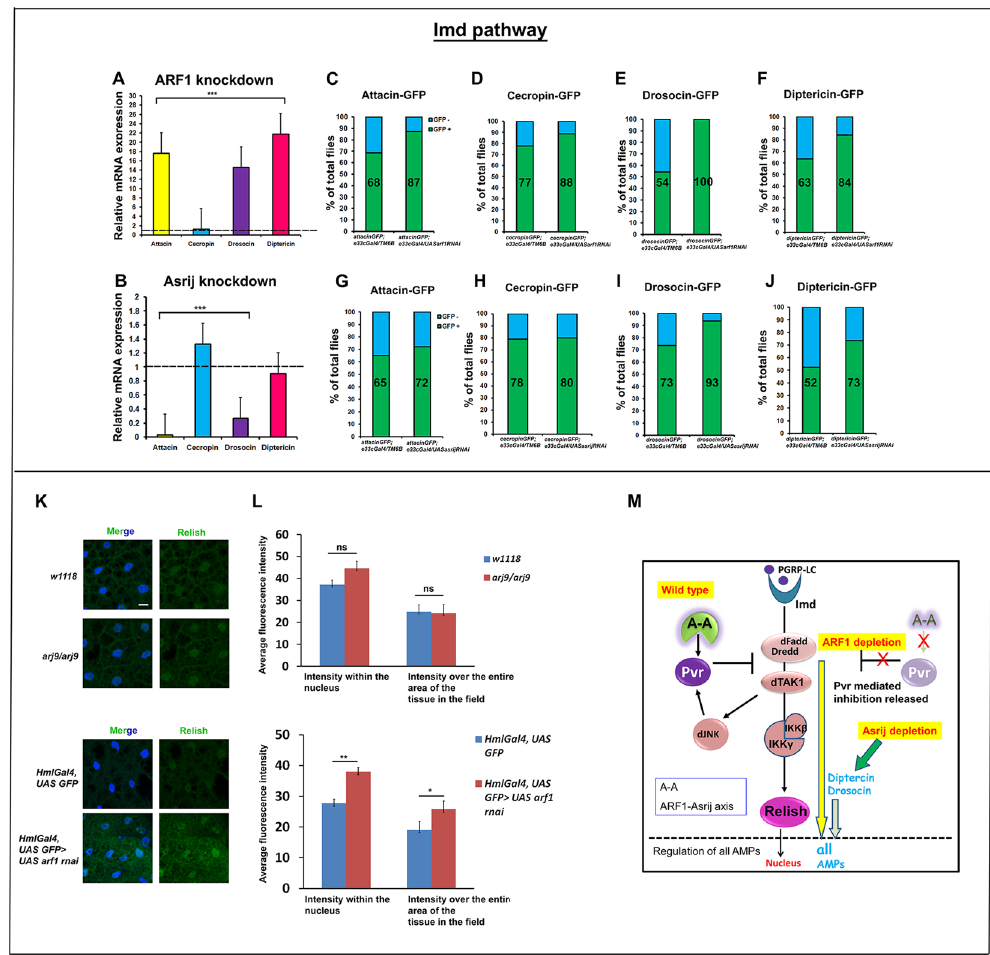
Figure 4. ARF1 and Asrij differentially regulate the Imd pathway. ( A , B ) Quantification of Imd pathway- governed antimicrobial peptide expression by qRT-PCR analysis shows that Attacin , Drosocin and Diptericin are highly up-regulated whereas Cecropin levels are unaffected in e33cGal4 -mediated ARF1 knockdown flies ( A ). Cecropin levels are upregulated and Attacin , Drosocin , Diptericin levels are down-regulated in e33cGal4- mediated Asrij knockdown flies ( B ). ( C – J ) Quantification of the total percentile of flies expressing the Imd pathway reporters - Attacin-GFP, Cecropin-GFP, Drosocin-GFP and Diptericin-GFP in flies with e33cGal4 mediated ARF1 knockdown ( C – F ) or asrij knockdown ( G – J ) respectively. ( K ) Images showing unchanged intensity of Relish in the nucleus of arj9 / arj9 larval fat body but increase in the intensity in arf1 knockdown larval fat body compared to the respective controls. Scale bar 10 µ m. ( L ) Quantification of Relish intensity over the entire area of the tissue in the field of view as well as in the nucleus (DAPI stained area) in arj9 / arj9 and arf1 knockdown fat bodies and in the respective controls (n = 10). Error bar represents standard error of mean. ns indicates statistically non-significant difference. * and ** indicates P-value < 0.05 and < 0.01 respectively. ( M ) Model indicating the suggested role of the ARF1-Asrij endocytic axis in regulating the Imd